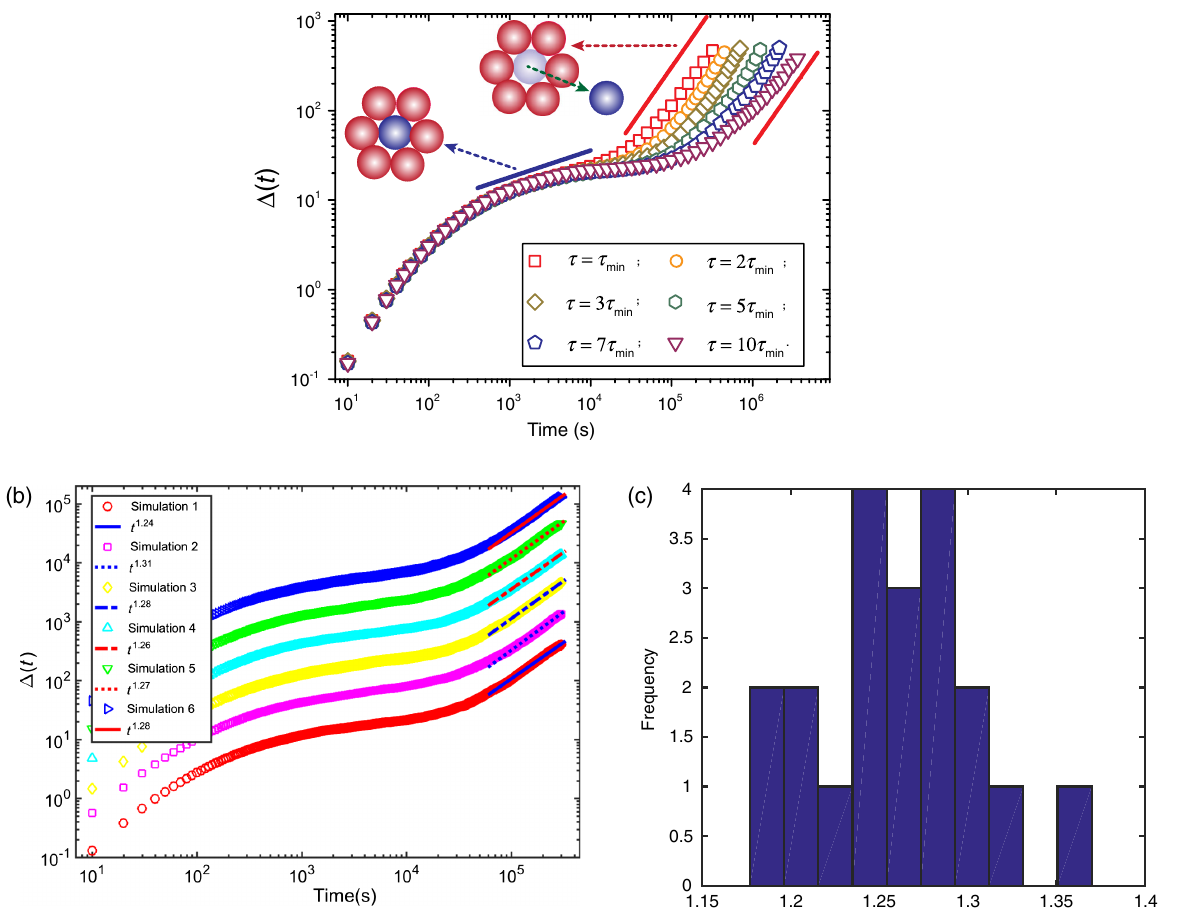
FIG. 5. Superdiffusive behavior in Δ ð t Þ at long times. (a) The mean-square displacement [ Δ ð t Þ ] of cells. From top to bottom, the 54 000 s). Time taken for reaching curves correspond to increasing average cell cycle time ( τ is varied from τ to 10 τ , where τ min min min ¼ the superdiffusive regime increases by increasing τ . The blue and red lines have slopes of 0.33 and 1.3, respectively. The subdiffusive (superdiffusive) behavior corresponds to dynamics in the intermediate (long) times. The left and middle inset illustrate the “ cage effect ” and “ cage-jump ” motion, respectively. The unit for the y -axis is μ m 2 . (b) Fit of the mean-square displacement Δ ð t Þ to t α for several simulation runs. Each Δ ð t Þ plot is averaged over approximately 300 cell trajectories. The six Δ ð t Þ plots consistently show α > 1 . 20 over approximately 1800 cell trajectories. The plots are separated for clarity. (c) Distribution of α values from multiple independent simulations. The mean value of α is 1.26, with a standard deviation of (cid:2) 0 . 05